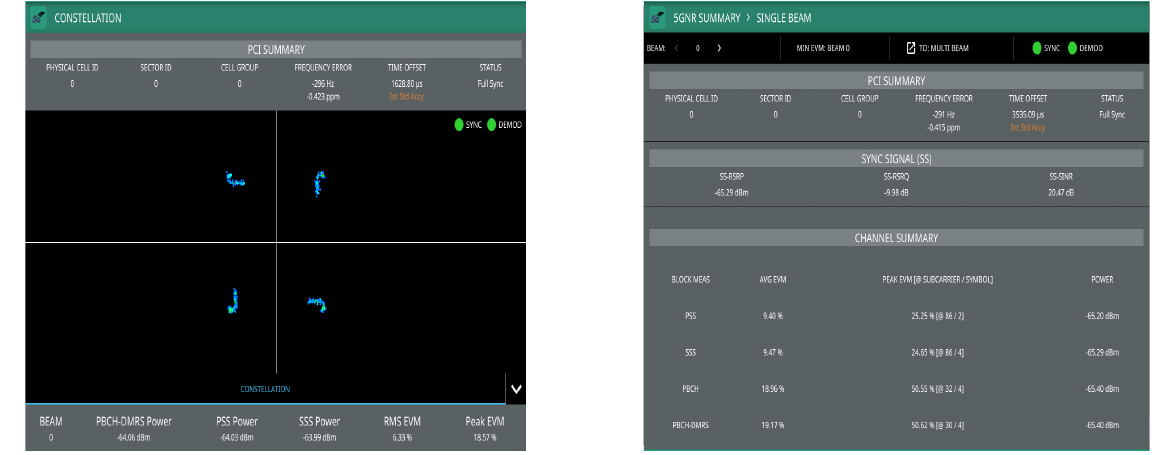
Figure 16. Demodulated PBCH and 5G summary of access link though the Anritsu analyzer. The rest of the discussed results have been obtained through the implemented